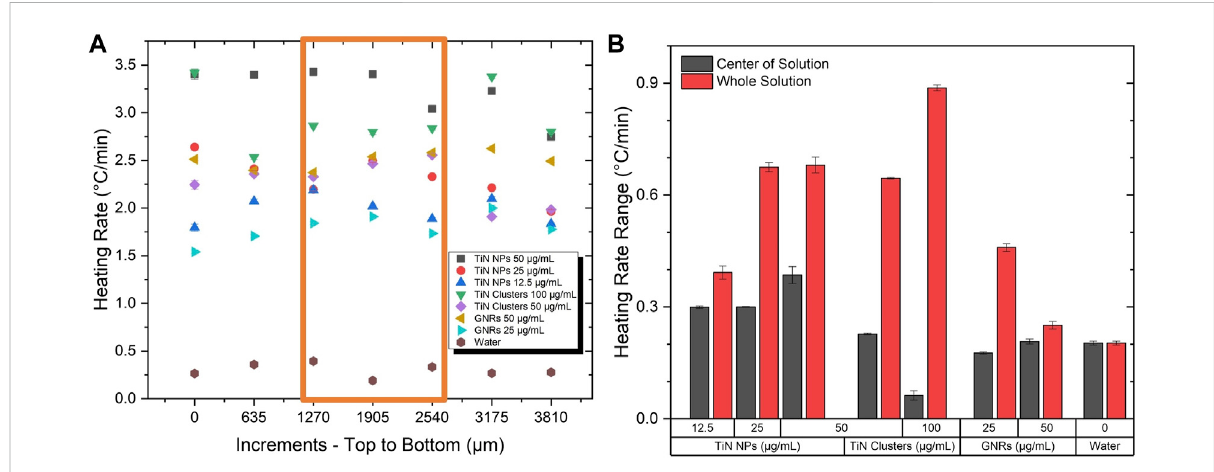
FIGURE 5 Testing of scattering properties. (A) The heating rate at various locations in a volume of 500 μ L at a power of 350 mW. (B) The change in the heating rate pro fi le in the center where the laser beam passes through and the whole solution.